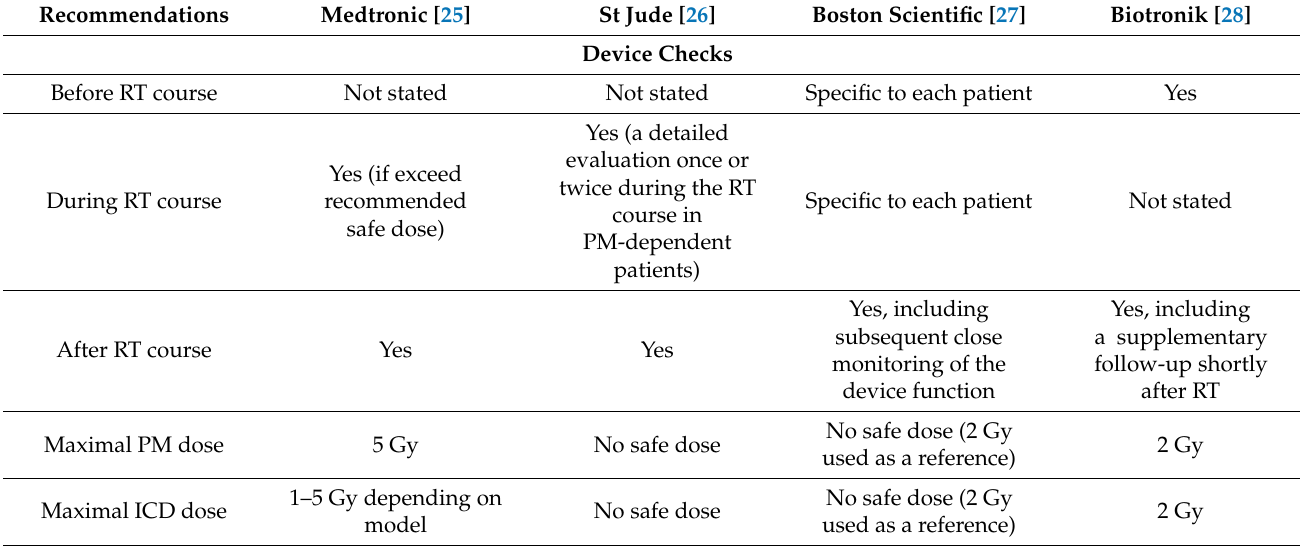
Table 4. Summary of recommendations from the major PM/ICD manufacturers regarding safe radio- therapy in CIED patients. CIED, cardiac implantable electronic device; Gy, gray; ICD, implantable cardioverter defibrillator; MV, megavolt; PM, pacemaker; RT, radiotherapy. Summary of Recommendations from the Major CIED Manufacturers Regarding Safe Radiotherapy in CIED